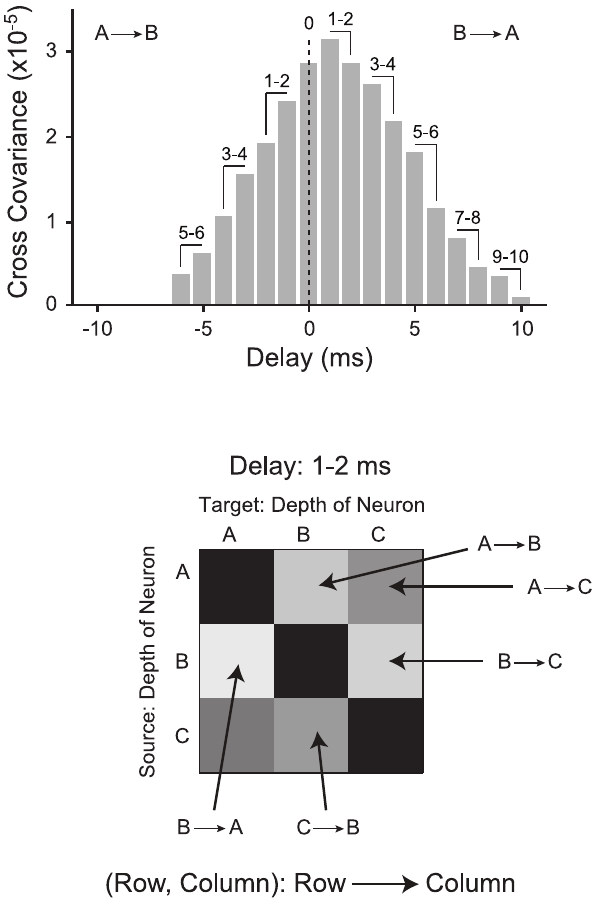
(Figure 10C: r= 0.379, p , 0.01, t-test) STRF subfields. Even